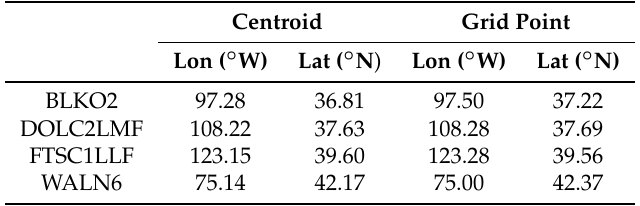
Table 1. Drainage area centroids and corresponding GEFS grid